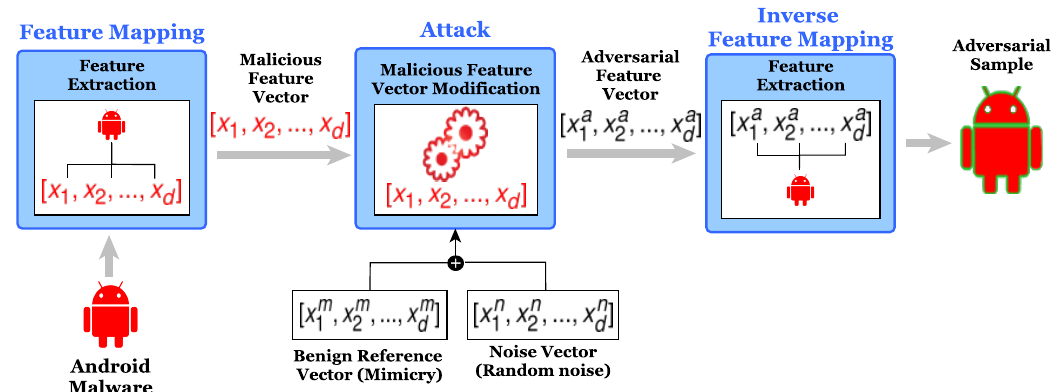
Figure 3. The architecture of the system. Firstly, it processes the given malicious sample to retrieve its feature vector. Then, it performs the modifications to the feature vector using either the benign reference vector (mimicry) or the noise vector (random noise adding). Finally, it generates the adversarial malicious